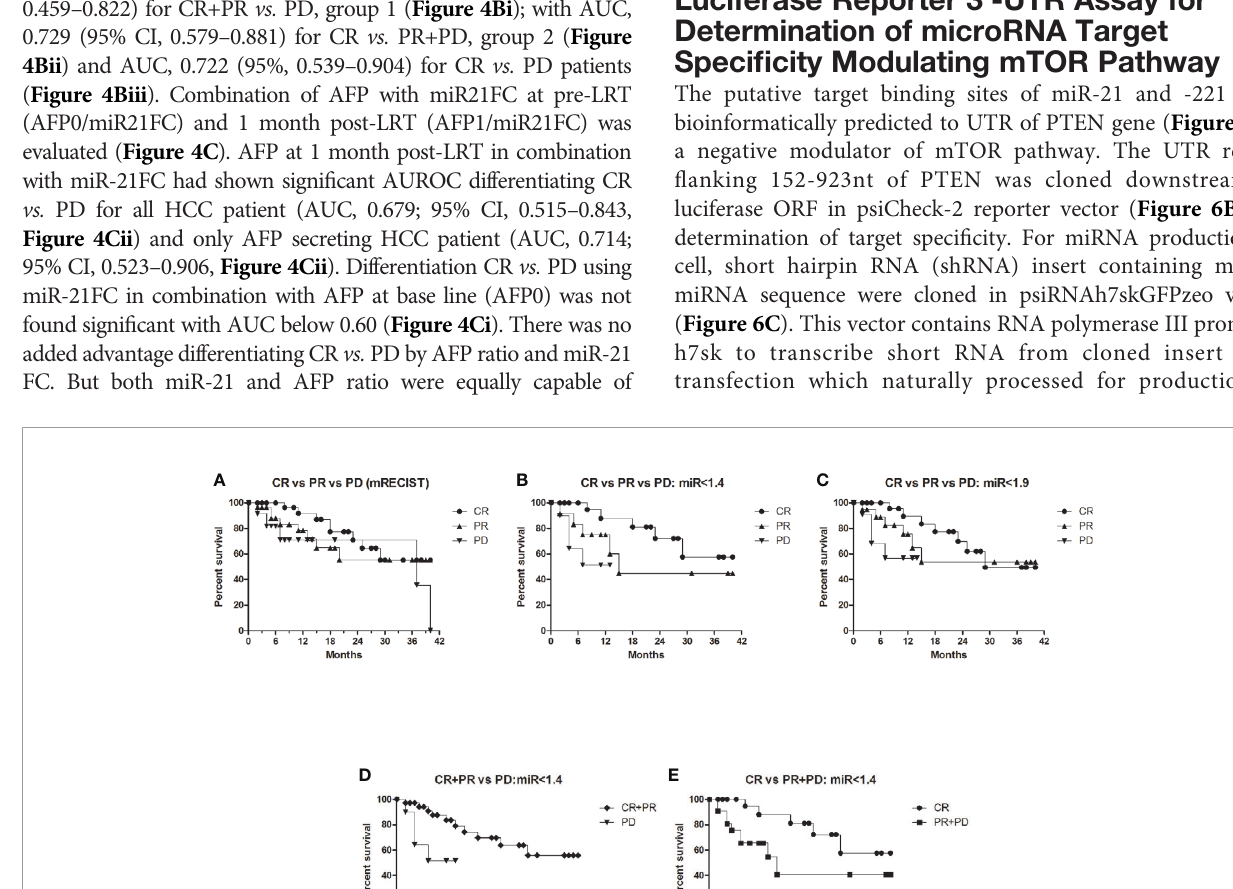
( Figure 4Biii ). Combination of AFP with miR21FC at pre-LRT (AFP0/miR21FC) and 1 month post-LRT (AFP1/miR21FC) was evaluated ( Figure 4C ). AFP at 1 month post-LRT in combination with miR-21FC had shown signi fi cant AUROC differentiating CR vs. PD for all HCC patient (AUC, 0.679; 95% CI, 0.515 – 0.843, Figure 4Cii ) and only AFP secreting HCC patient (AUC, 0.714;